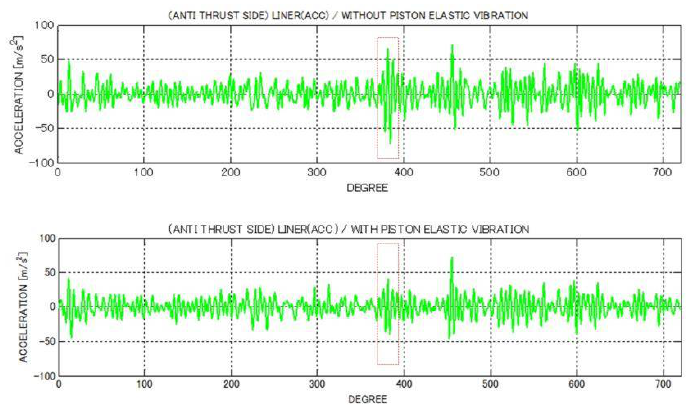
Figure 6. Vibration acceleration of the central part of the liner with/without dynamic features of the piston.